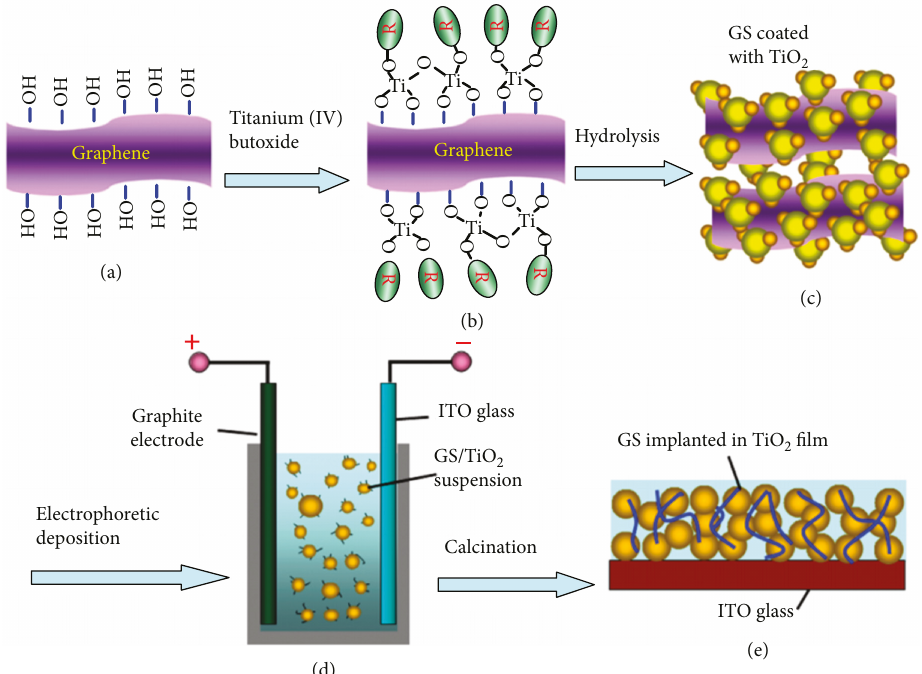
fi lms. (a) GS prepared by chemical exfoliation with Figure 8: Schematic fl owchart of in situ incorporation of GS in nanostructured TiO 2 residual oxygen-containing functional groups, such as hydroxyl. (b) Schematic of titanium(IV) butoxide grafted on the reduced GS surfaces by chemisorption. (c) Schematic diagram of GS coated with TiO colloids after hydrolysis. (d) Illustration of the electrophoretic 2 deposition process used to prepare GS/TiO composite fi lms. (e) Schematic representation of the structure of the GS/TiO composite fi lm 2 2 after calcination